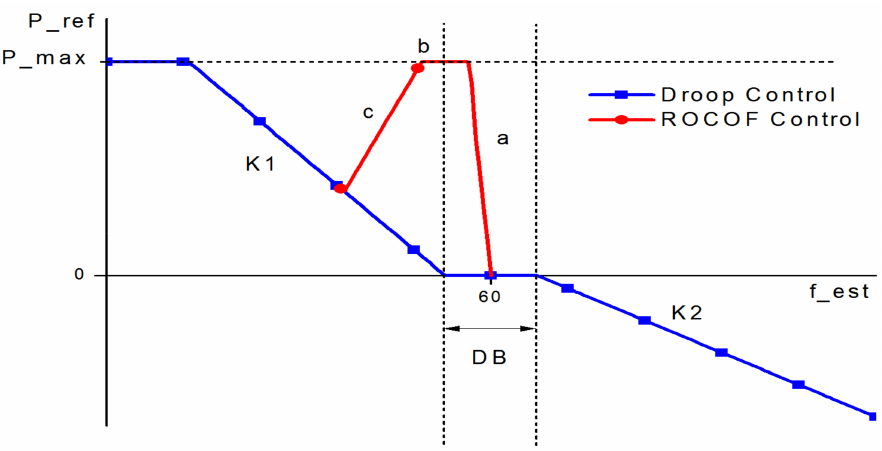
Figure 3. BESS output graph with FDC according to the system frequency and using Rate of Change of Frequency (ROCOF)